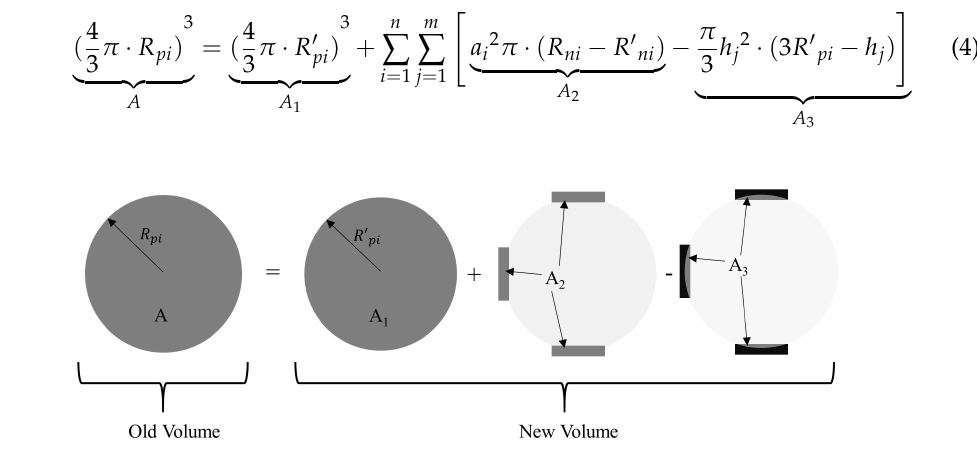
Figure 10. Visualisation of new radius